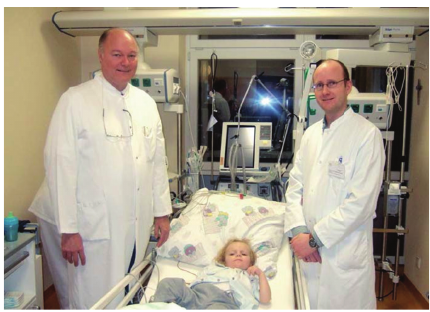
Figure 6: First autologous cord blood transplantation after global hypoxic-ischemic brain damage caused by cardiac arrest in a boy 2.5 years of age (see [43]). Nine weeks after the insult the patient (L. B.) received an autologous cord blood transplantation to treat cerebral palsy (January 27, 2009). The boy was normally developed when brain damage occurred, that was followed by a quadriplegic persis- tent vegetative state (see video S3 in Supplementary Material